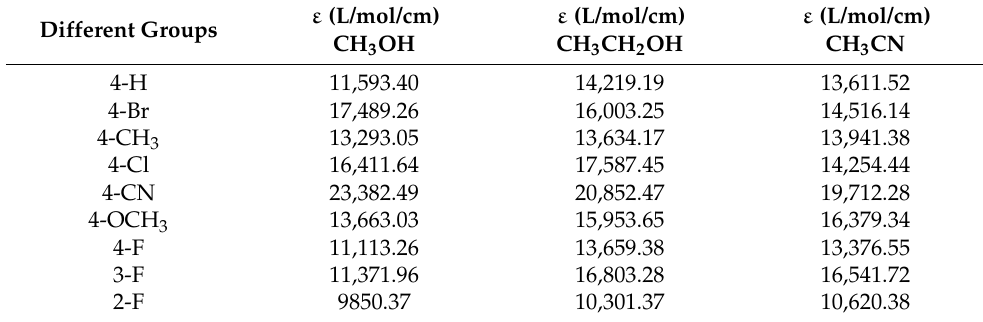
Different Groups